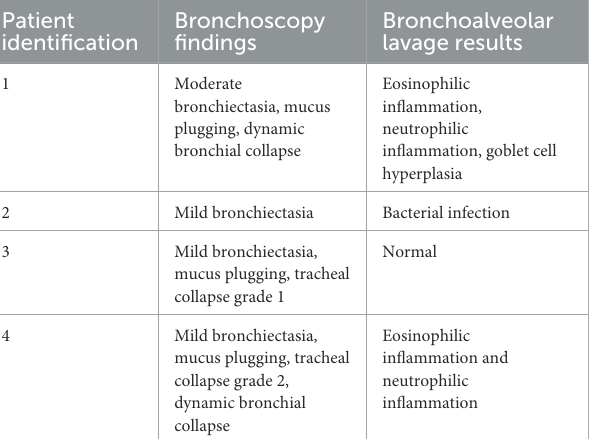
TABLE 3 Bronchoscopy and BAL